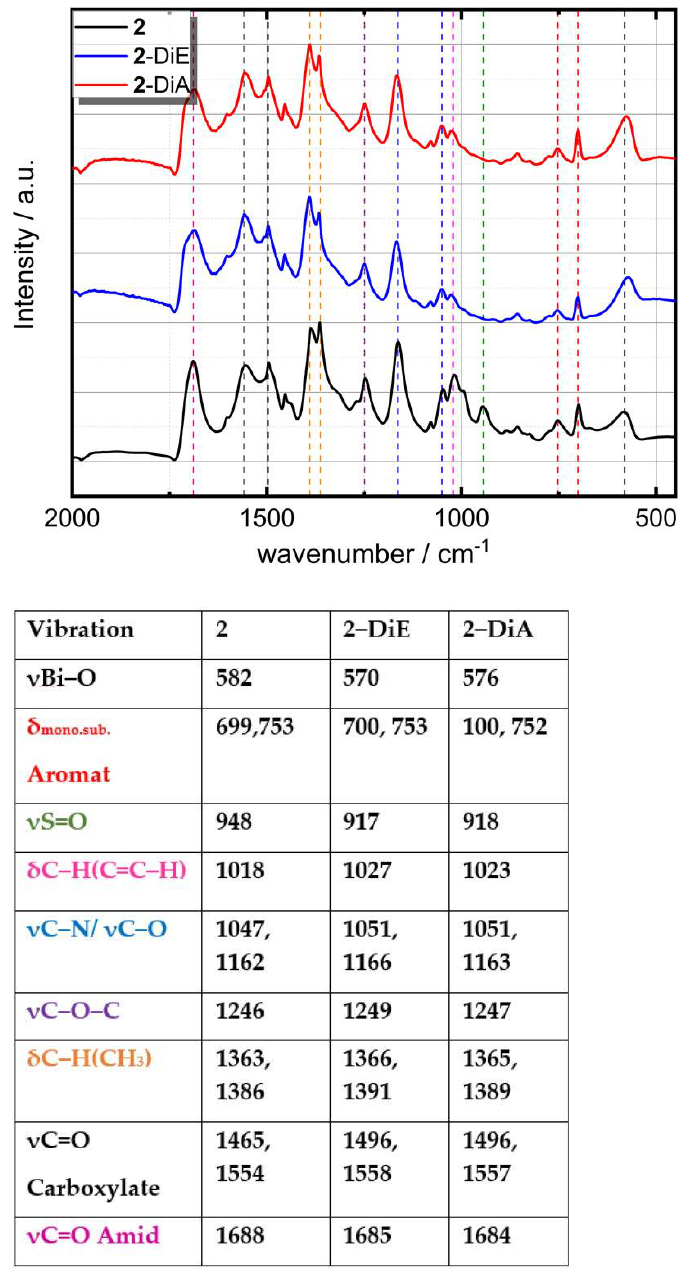
Figure 3. FTIR spectra of thin films of 2 deposited by dip coating from acetonitrile ( 2 −DiA) or ethanol ( 2 −DiE) solution and comparison to pure powder of 2 , with the associated modes shown in the table on the right-hand side (values given in cm −1 ).